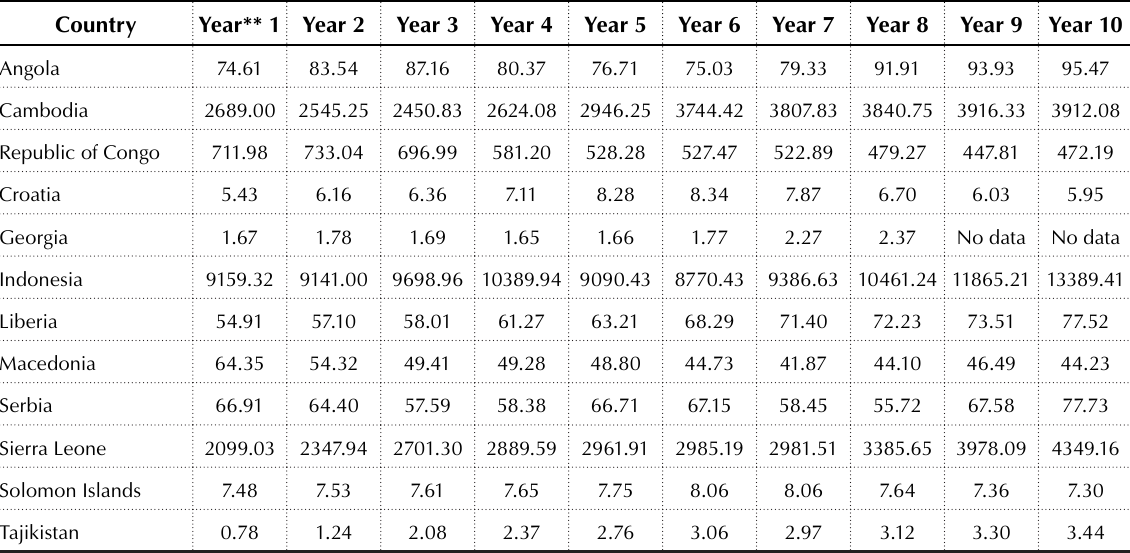
Table 2. Official exchange rate, local currency per US dollar